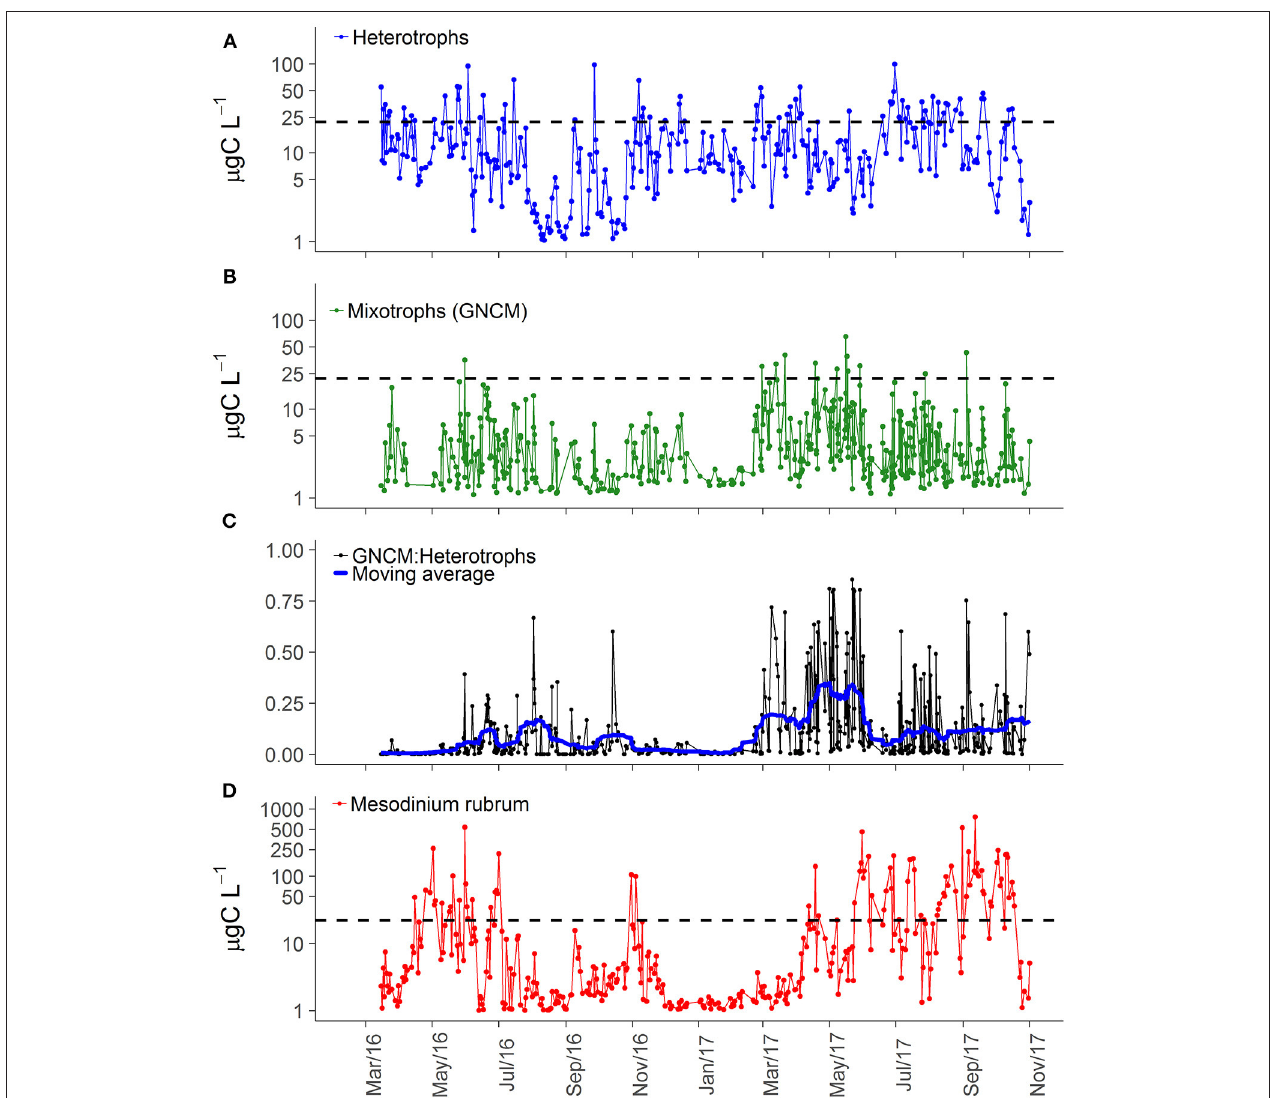
FIGURE 3 | Carbon biomass of three main ciliate groups in Roskilde Fjord (A, B, D) and the biomass proportion between GNCM and heterotrophic ciliates (C) . The black dashed horizontal lines in panels (A, B, D) represent the average of total ciliate biomass (22.26 µ g C L − 1 ) over the entire study period. The thick blue line in panel c represents the centered moving average, using a 15 days